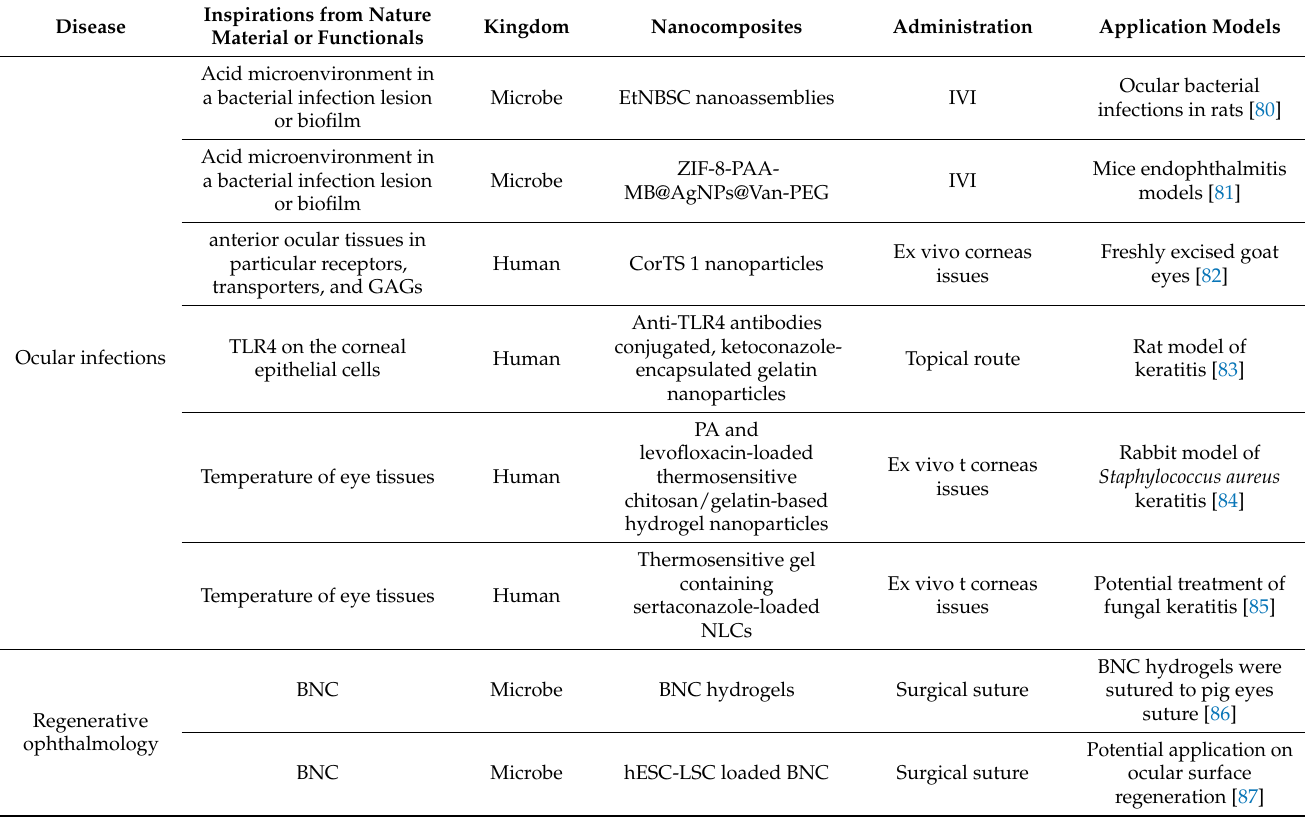
Table 2. The applications of bioinspired nanocarrier for anterior segment ocular